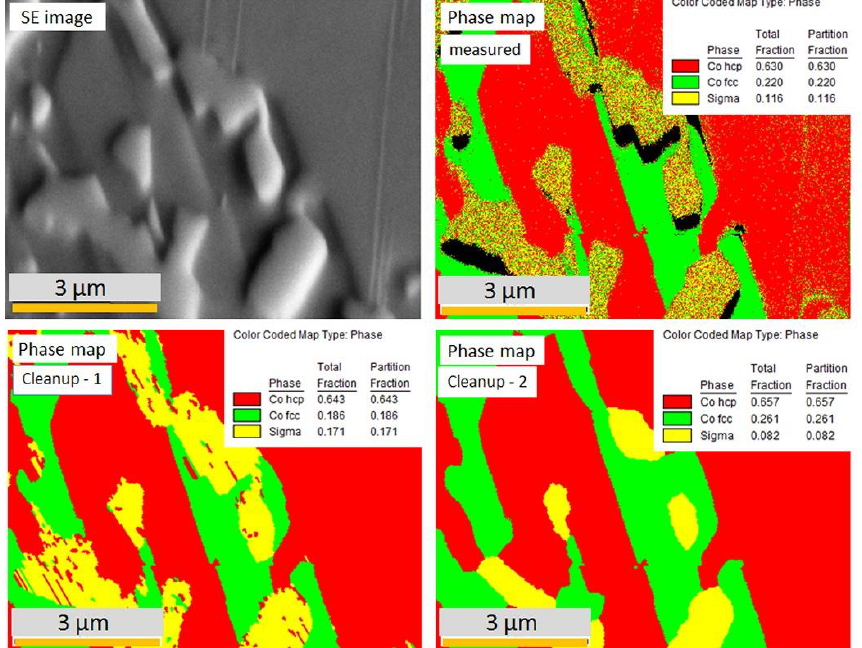
Figure 3. EBSD maps showing artefacts of clean-up procedure for correcting wrongly indexed phases: SE image of the selected area; measured EBSD map, Cleanup-1 procedure using Neighbour Phase Correlation plus Grain Dilation, Cleanup-2 procedure using Grain Dilation only.